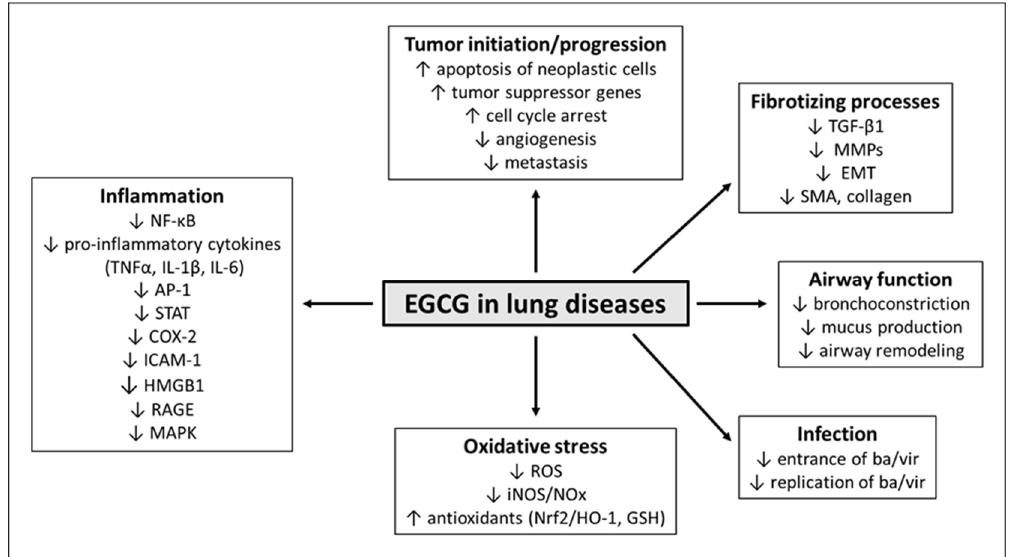
Figure 3. Major effects of EGCG in the lung diseases. Abbreviations: AP-1: activator protein 1, ba: bacteria, COX-2: cyclooxygenase-2, EGCG: epigallocatechin-gallate, EMT: epithelial–mesenchymal transition, GSH: glutathione, iNOS: inducible nitric oxide synthase, HMGB1: high-mobility group